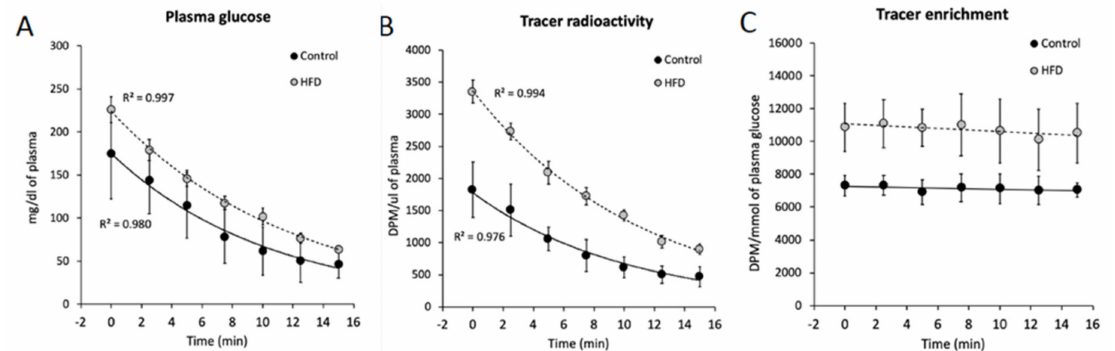
Figure 7. Plasma glucose and 2-deoxy-[1,2-3H (N)]-D-glucose profiles during 0.5U / Kg intraperitoneal insulin challenge. Panel A —plasma glucose concentration; Panel B —plasma 2-deoxy-[1,2-3H (N)]- d -glucose tracer radioactivity; Panel C —plasma glucose tracer enrichment after intravascular tracer and insulin bolus injection. Values are mean ± SD; n = 8 per